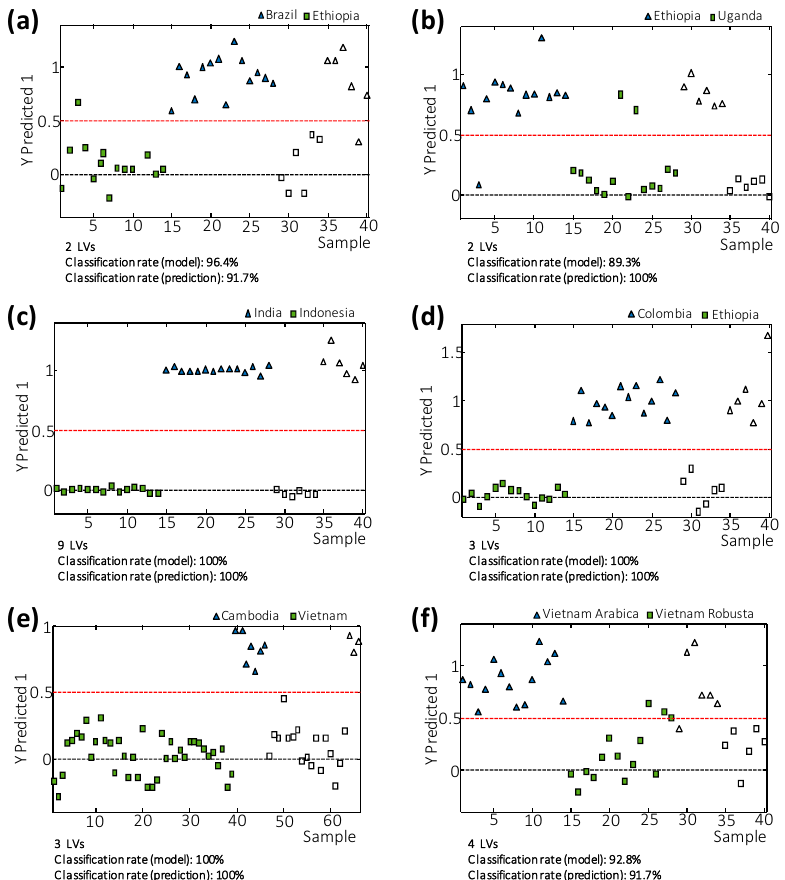
Figure 5. Sample vs. Y predicted 1 values plot for ( a ) Brazilian vs. Ethiopian coffees, ( b ) Ethiopian vs. Uganda coffees, ( c ) Indonesian vs. Indian coffees, ( d ) Colombian vs. Ethiopian coffees, ( e ) Vietnamese vs. Cambodian coffees, and ( f ) Vietnamese Arabica vs. Vietnamese Robusta coffees. Filled and empty symbols correspond to calibration and validation sets, respectively. Dashed red lines represented the threshold separating one class from the other. The number of latent variables (LVs) employed to generate each classificatory model and sample classification rate are also indicated.